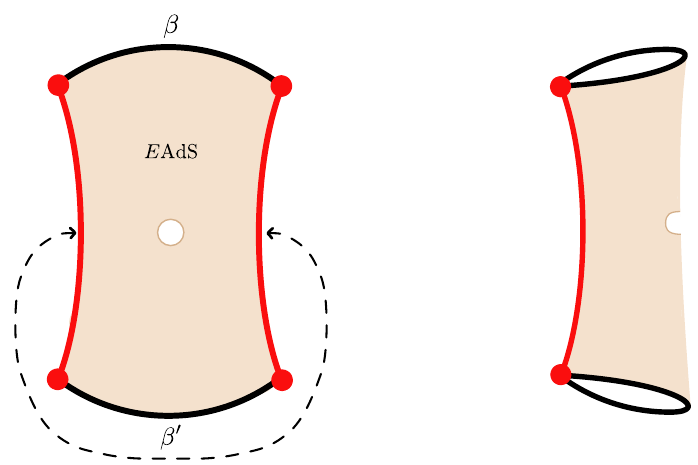
Figure 6 . Deconstruction of the AdS wormhole. The geometry corresponds to a portion of Eu- clidean AdS, cut by the trajectories of two thin shells, which are then identified. The periodicity β AdS of the AdS solution only depends on the combination β + β 0